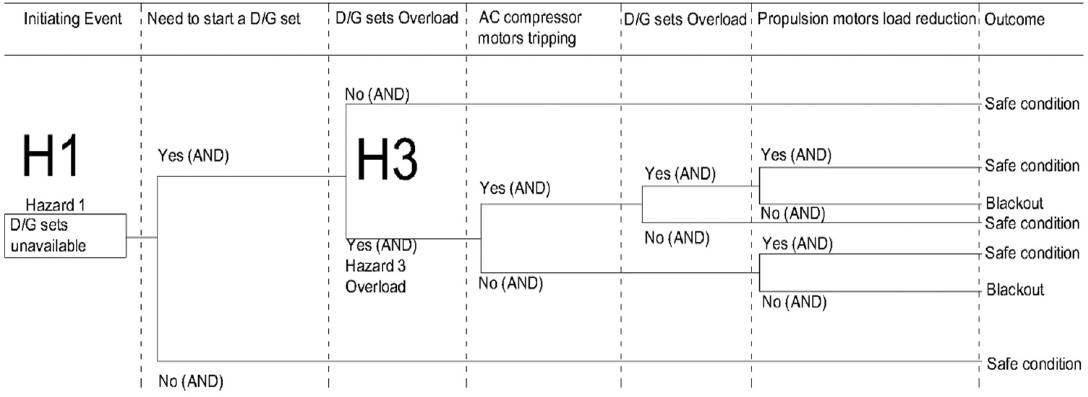
Figure 6. ESI’s “Event Tree” for first (H-1) and third (H-3) sub